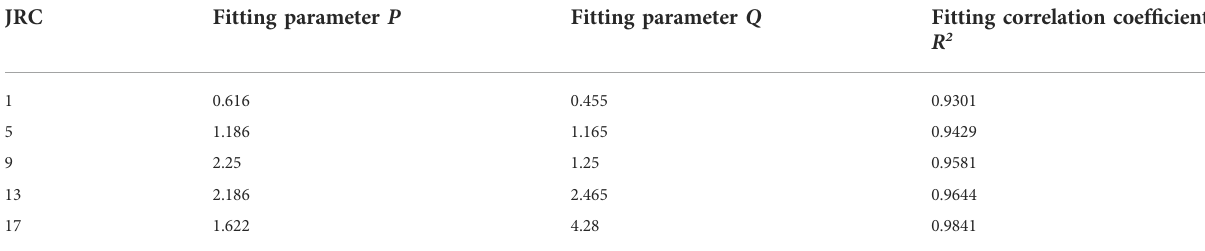
TABLE 6 Fitting parameters of the linear